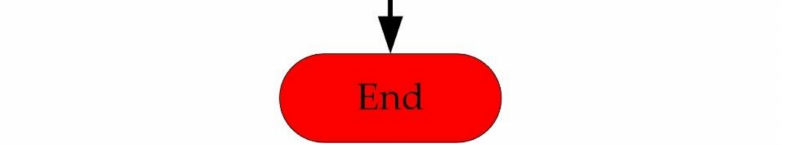
Figure 1. Flow chart of engine rotor assembly